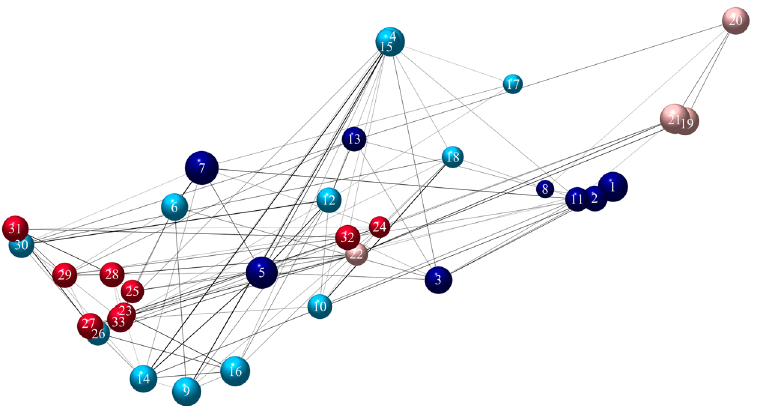
Figure 4. Spatial network of genetic variation with four detected modules (different colors). Links represent significant genetic similarity with line thickness positively correlated to the level of similarity. Node size shows population heterozygosity and node position reflects the geographic position. Population 1 to 18 and 19 to 33 are grassland and forest populations